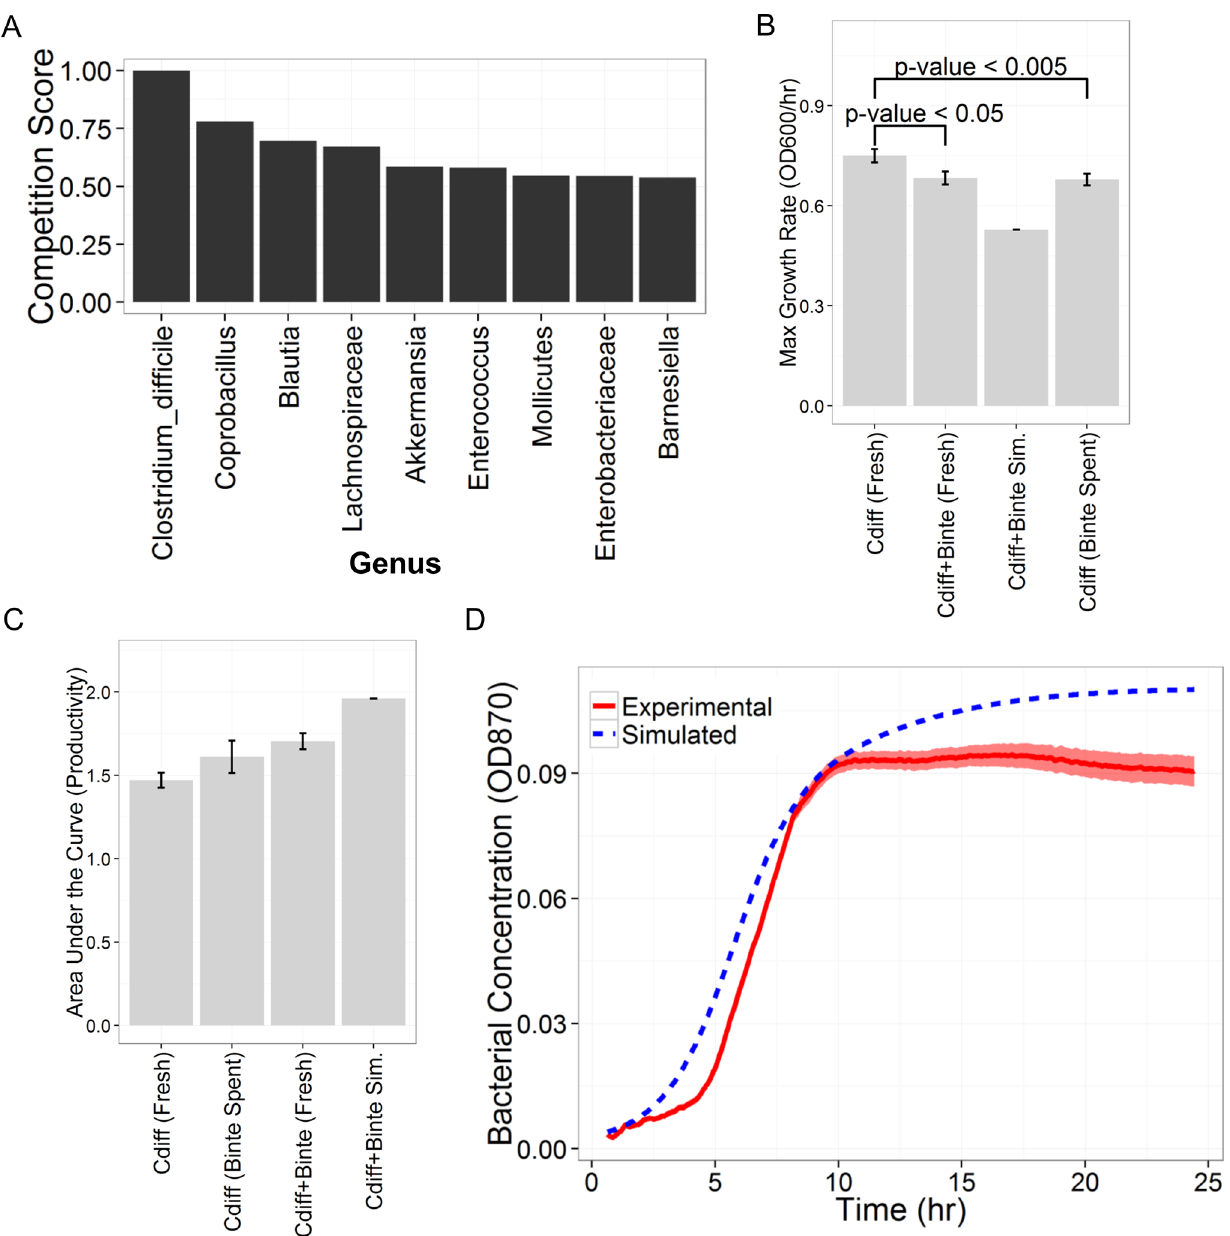
Fig 5. Metabolic competition scores and in vitro data indicate a non-metabolic interaction mechanism. A) Competition scores for all pairs of genera with C . difficile . Notice that Barnesiella has nearly the lowest competition score. B) Maximum growth rates for all growth conditions. C . difficile grew more slowly in B . intestinihominis spent media (n = 16, p-value < 0.005, by one-sided Wilcoxon rank sum test). The co-culture with both B . intestinihominis and C . difficile grew more slowly than C . difficile alone (n = 16, p-value < 0.05, by one-sided Wilcoxon rank sum test). C) Area under the curve (AUC) was not significantly different for C . difficile in fresh media or B . intestinihominis spent media (n = 16, p-value = 0.22 by one-sided Wilcoxon rank sum test). D) The experimental (red, solid line) and simulated (blue, dashed line) co-culture growth curves. “ Binte ” indicates B . intestinihominis , while “ Cdiff ” stands for C . difficile . On average, the experimental co-culture growth curves maintained a lower density than the simply additive null model. Error bars represent the standard error of the mean from 16 independent replicates.